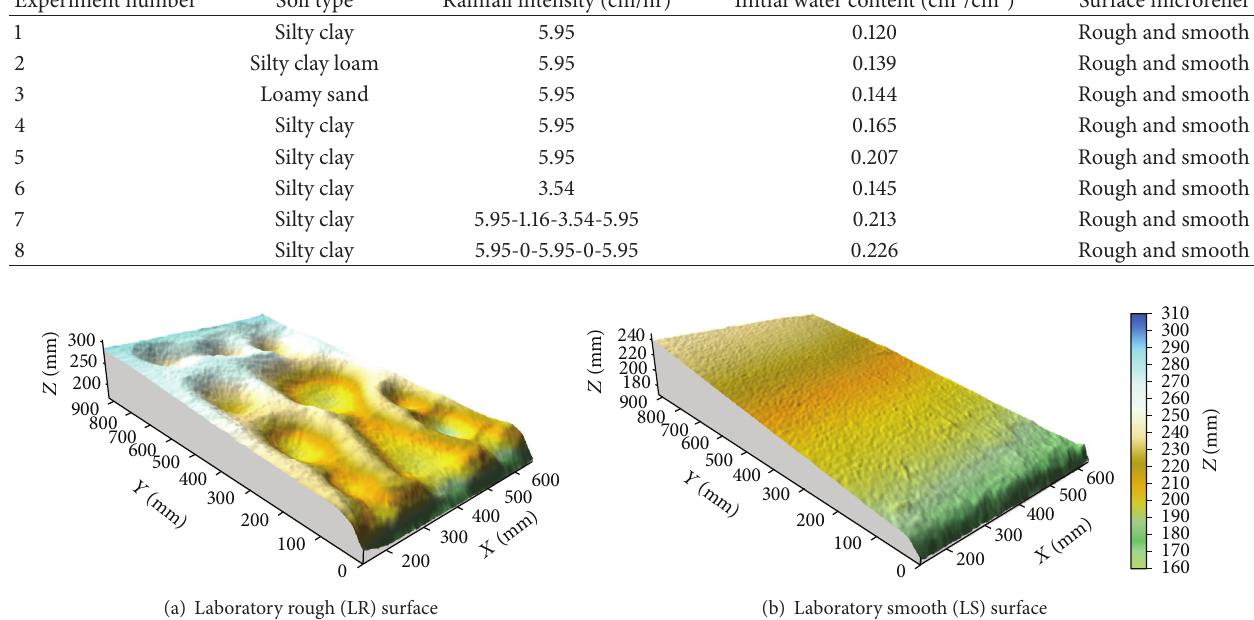
Figure 1: Rough and smooth soil surfaces used for laboratory overland flow